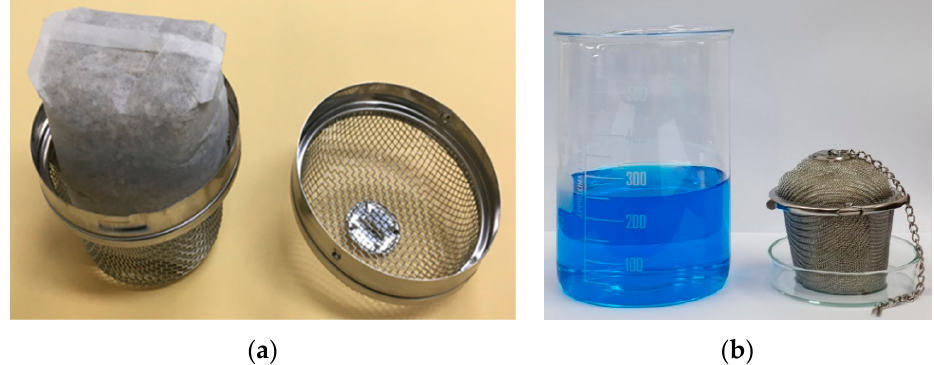
Figure 2. ( a ) Picture of the unlocked prototype absorbent assembly consisting of a stainless-steel mesh container and an absorbent paper pouch made of eVMTs. ( b ) Image of the experimental setup for a liquid mitigation test using the prototype absorbent assembly. The solution was intentionally colored by a blue dye for visibility.